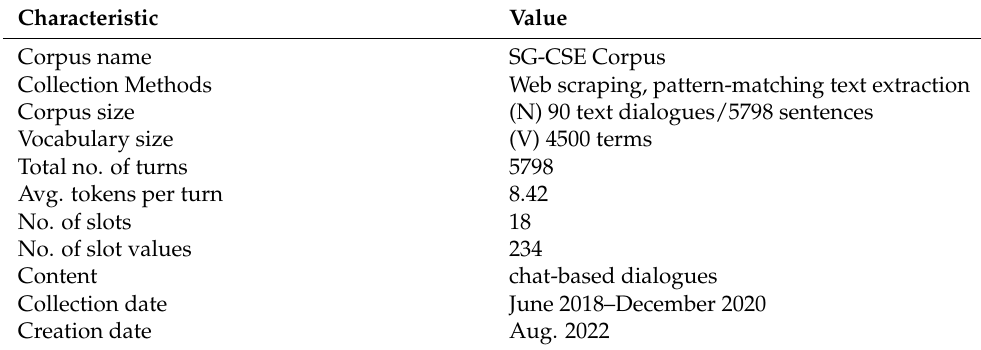
Table 5. SG-CSE Corpus identity.